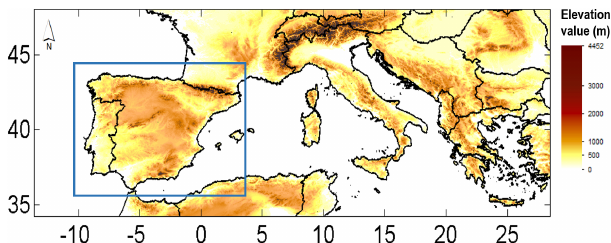
Figure 1. The Iberian Peninsula (blue box) in the Mediterranean region. Colour represents elevation (in